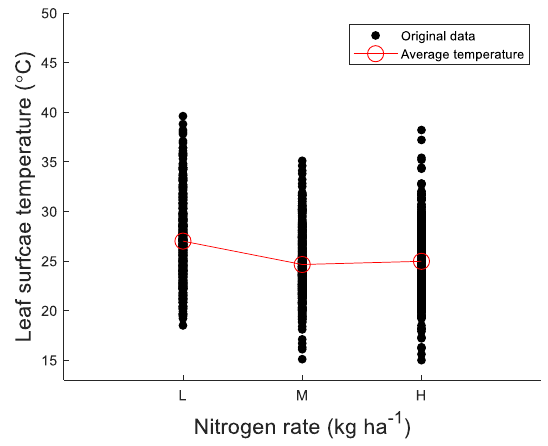
Figure 5. The inverse correlation between nitrogen rate and leaf surface temperature in the two experiments conducted under greenhouse conditions when three rates of nitrogen (low (L), medium (M), and high (H)) were supplied (2 nitrogen treatments × 10 data points/treatment × 2 experiments = 40 data points per treatment).